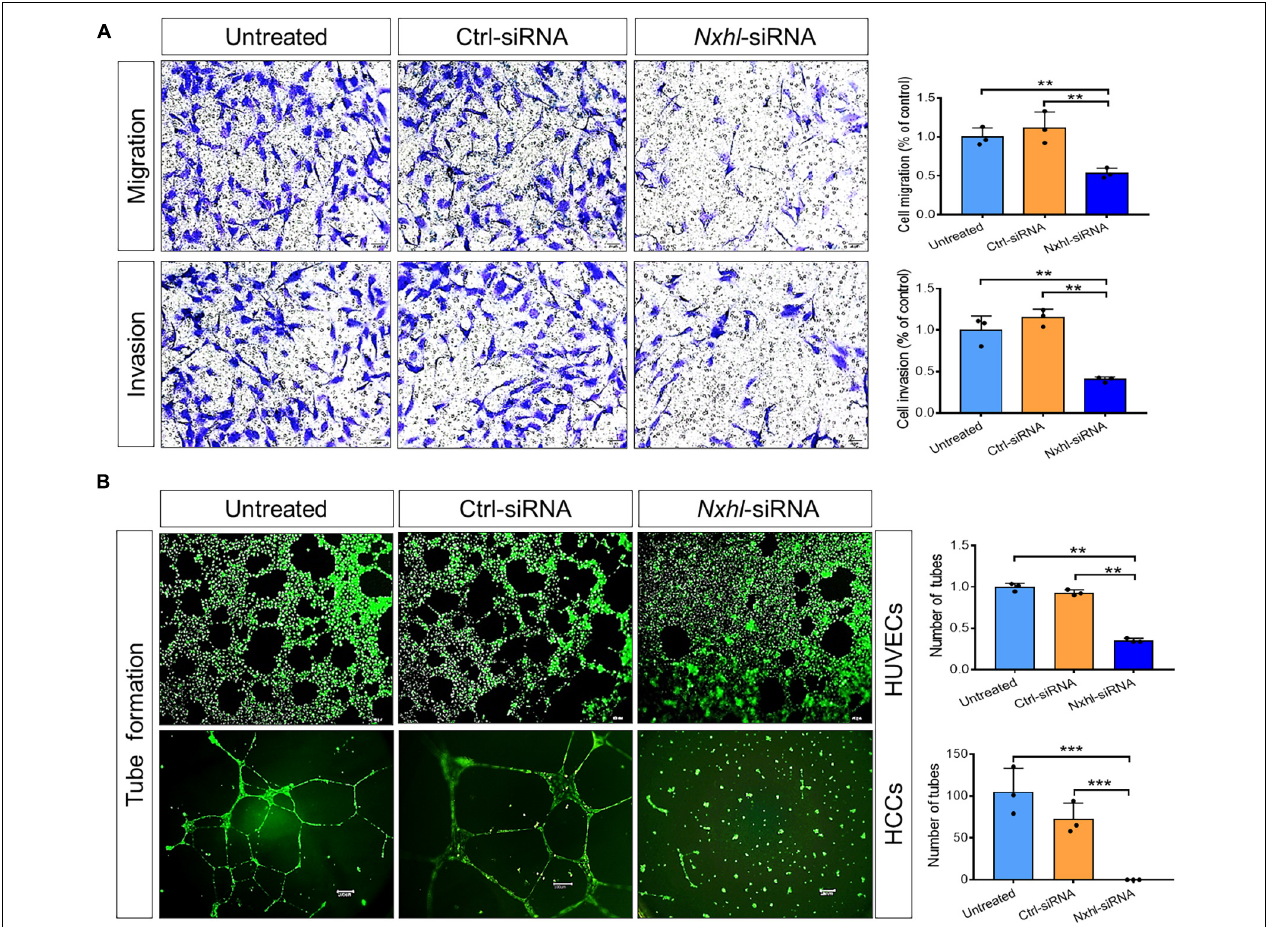
FIGURE 3 | Nxhl affects angiogenic phenotypes in vitro . (A) Silence of nxhl (homolog of Harbi1) gene suppresses HUVEC cell migration and invasion. Representative images of migrated and invasive cells stained with crystal violet and inhibition of migration in nxhl -siRNA treated HUVEC cells. The migration and invasive potential of HUVECs treated with nxhl -siRNA was determined using transwell chambers as described in the “Materials and methods” section. (B) Silence of nxhl gene suppresses HUVEC and HCC cell tube formation abilities. Representative images of tube formation in nxhl -siRNA treated HUVEC cells and inhibition of tube formation in vitro (up row). Images were taken 6 h after addition of the supernatant. Tube networks were quantified using the Image J software and expressed as branches. Scale bars, 50 µ m (middle row). Representative images of tube formation in nxhl -siRNA treated HCC cells (down row). Scale bars, 100 µ m. Images were taken 24 h after addition of the supernatant. Tube networks were quantified using the Image J software and expressed as branches. The data represent as mean ± SEM from three independent experiments. * p < 0.05, ** p < 0.001, and *** p < 0.0001 represents statistically